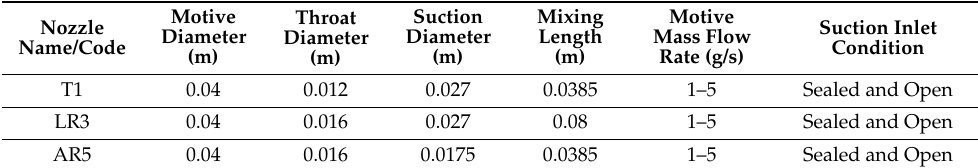
Figure 2. Air mixing experimental setup schematic. Table 1. Air mixing experimental test